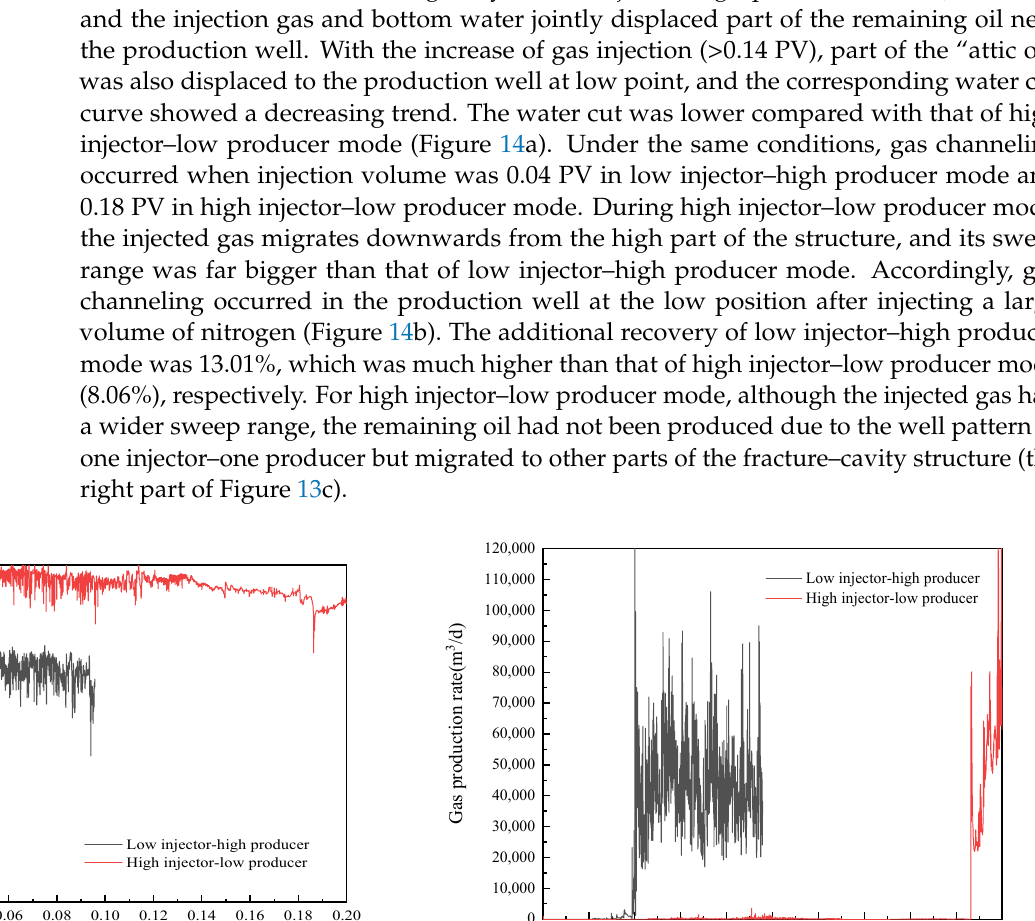
Figure 13. Fluid distribution in different stages of high injector–low producer mode: ( a ) initial stage; ( b ) last stage. The water cut fluctuated greatly in low injector–high producer mode (<0.02 PV), and